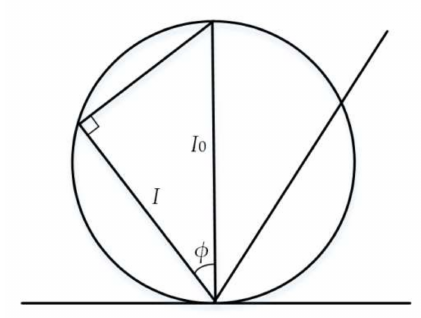
Figure 5. Lambert surface scattering field distribution.